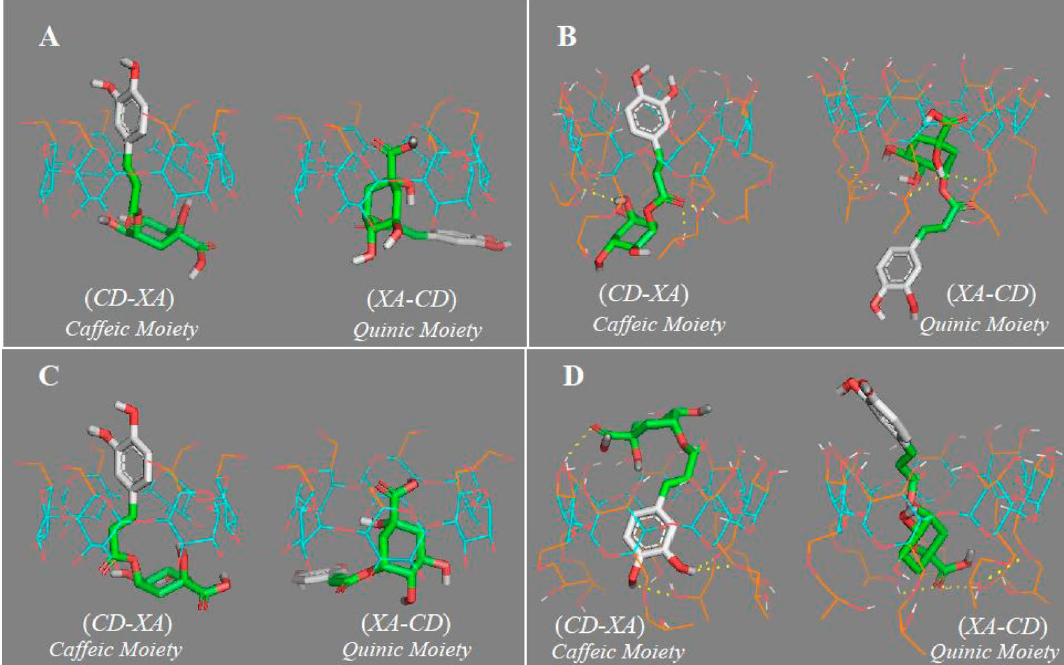
Figure 4. Most likely configurations of the molecular docking of neochlorogenic acid with ( A ) α-CD and ( B ) HP-β-CD, and chlorogenic acid with ( C ) α-CD, and ( D ) HP-β-CD, in the caffeic acid moiety ( CD-XA ) or quinic acid moiety ( XA-CD ). Flexible atoms of CDs are coloured orange and non-flexible atoms blue. Hydrogen bonds are yellow dotted lines.